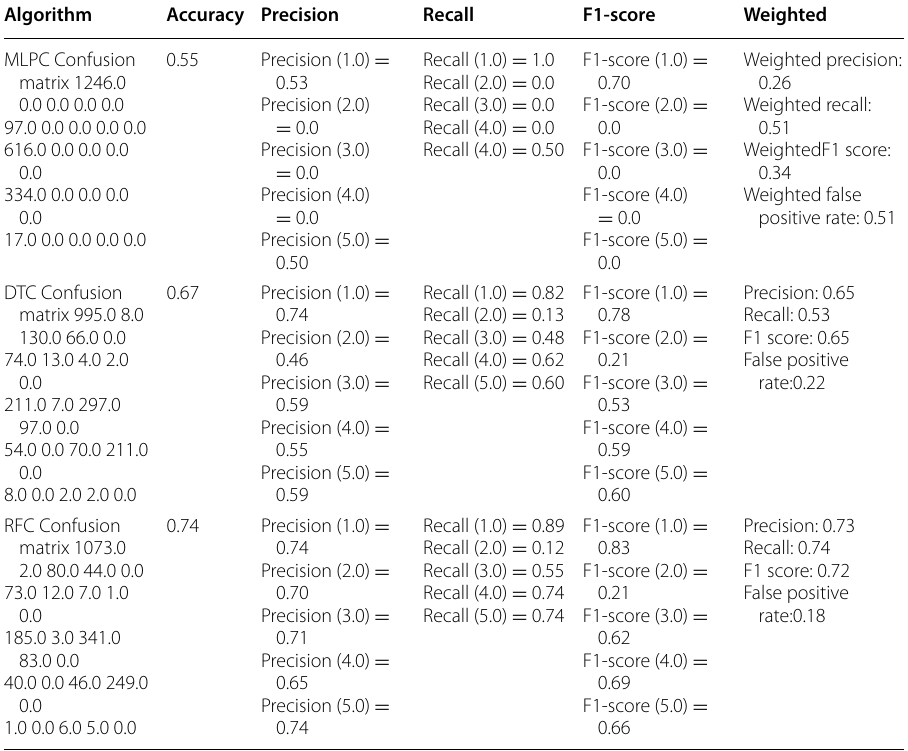
Table 16 Comparison of multiple classes to predict loyalty Algorithm Accuracy Precision